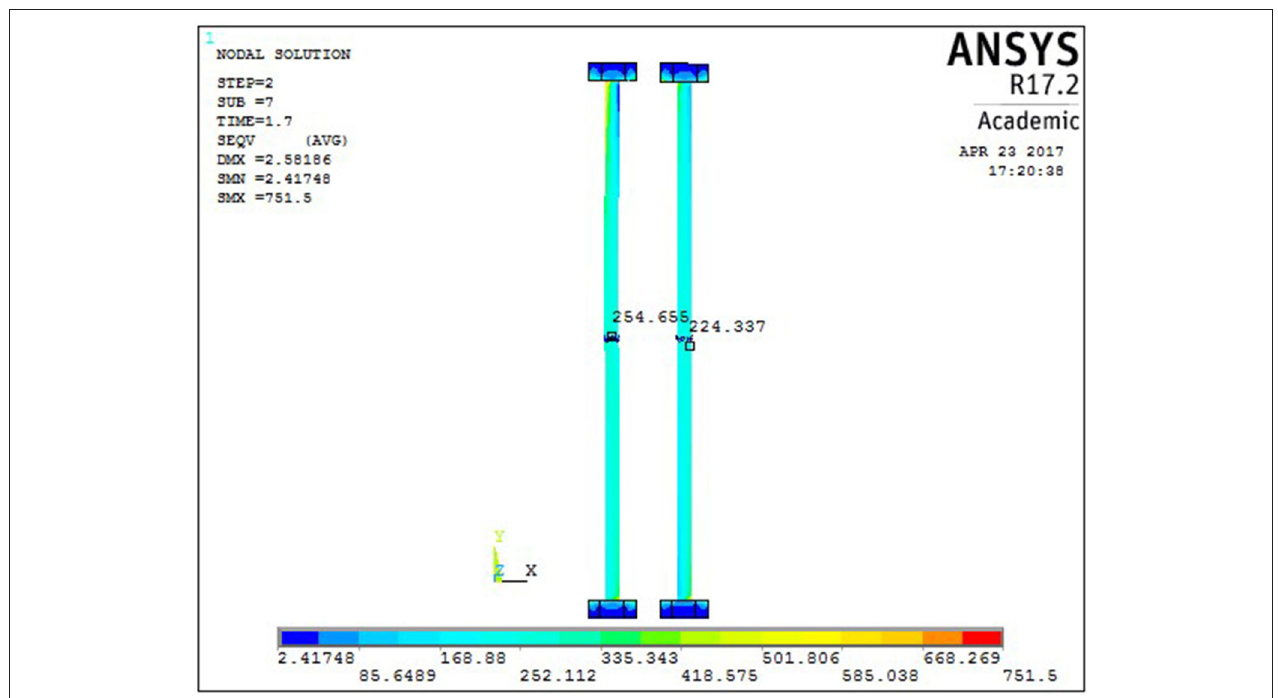
FIGURE 7 | Von Mises stress distribution in the vertical bolts for case 1.